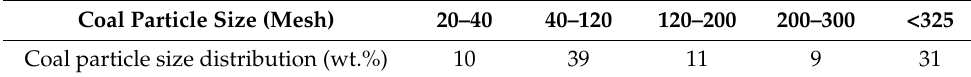
Table 2. Particle size distribution of the Zhundong coal sample. Coal Particle Size